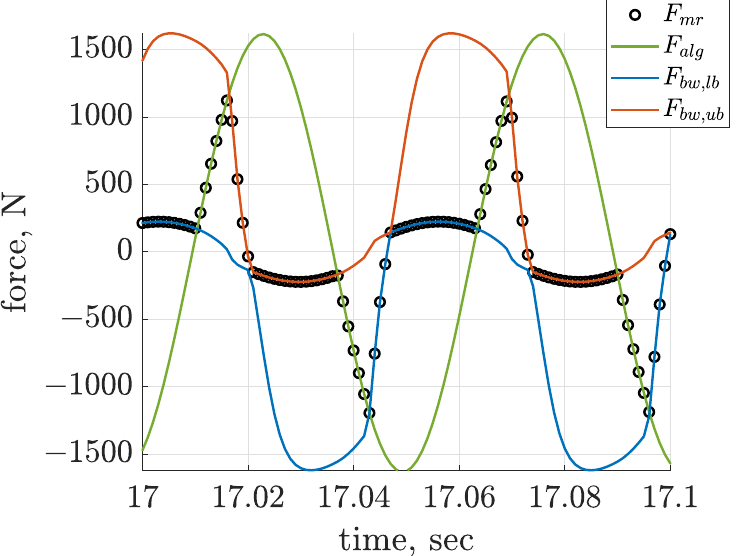
Figure 28. Quality of tracking of the vertical desired control force F alg , z by the actual MR damper Bouc–Wen F mr , z , accompanied by the lower F bw , lb and upper F bw , ub bounds, presented for the front screen suspension part for the control configuration of ∆ α alg = − 3/4 π